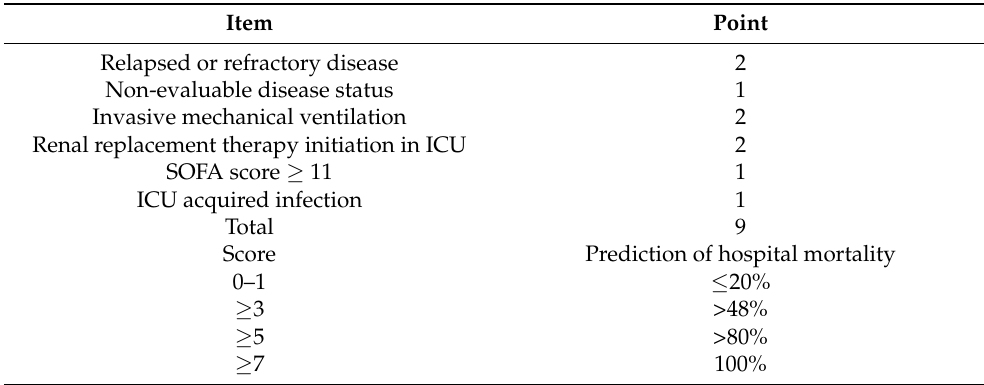
Table 5. HHM score for the prediction of hospital outcome in patients with hematological malignan- cies admitted to the intensive care